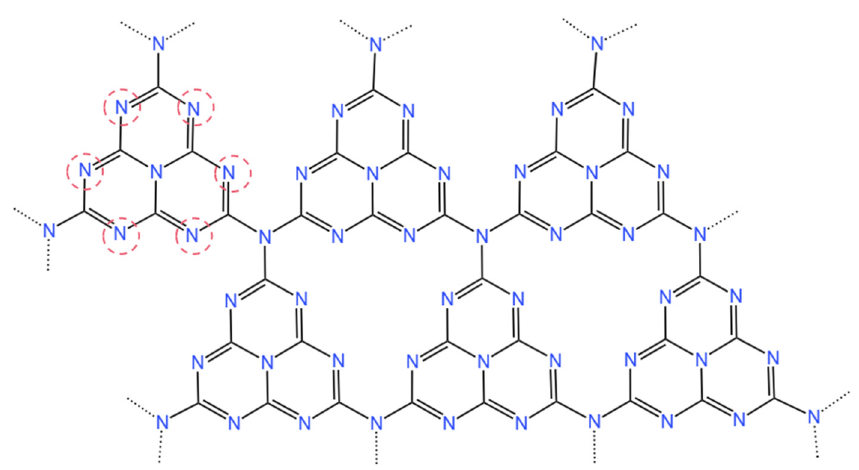
Figure 3. Heptazine structures of g-C 3 N 4 . The nitrogen atom circled by the red dotted line is pyridine nitrogen.